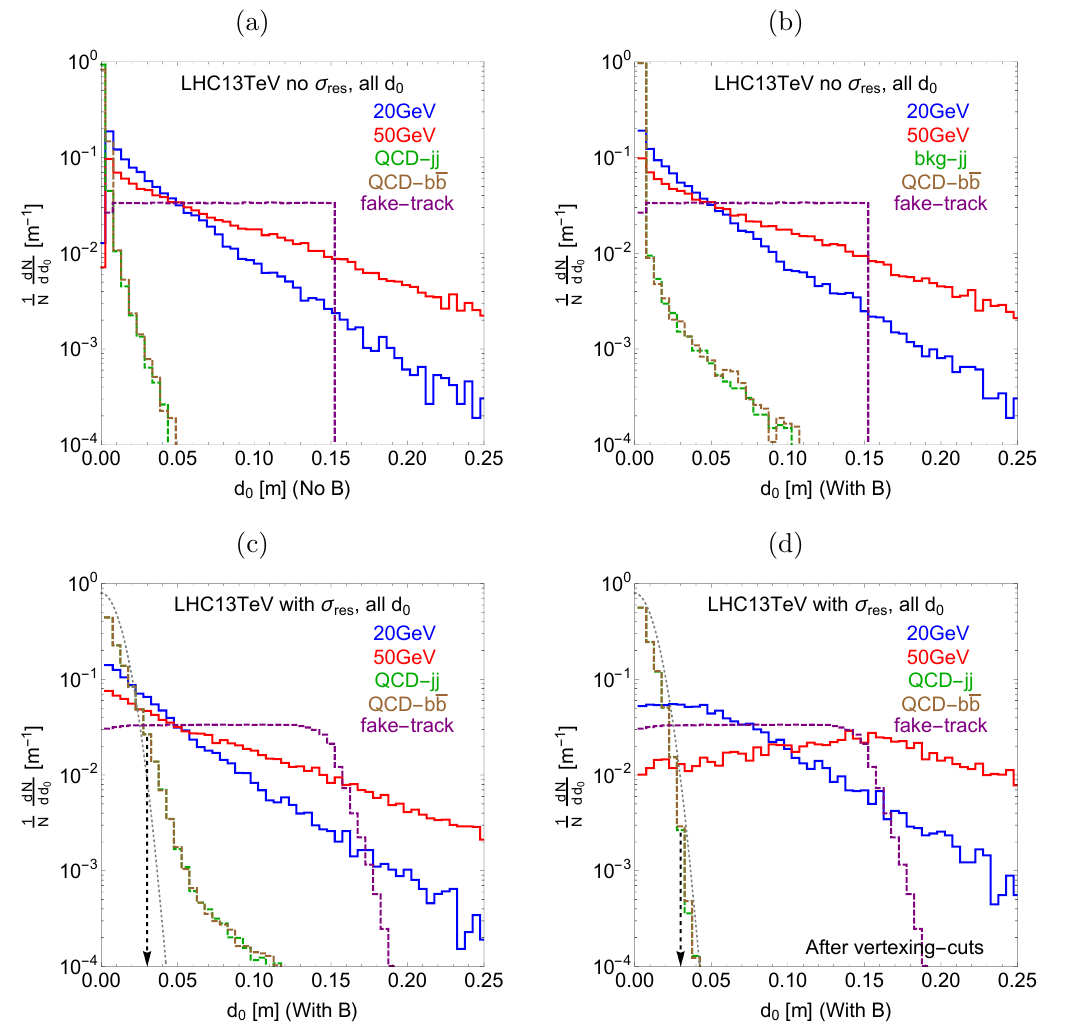
Figure 6 . The distributions of the transverse impact parameter d 0 for the QCD background, the fake-track background and the signal. Panel (a) has no angular resolution effect and no magnetic field. Panel (b) has no angular resolution effect but with a magnetic field of 3 . 8 T. Panel (c) has the angular resolution effect and the magnetic field. Panel (d) has both effects, and with vertexing-cuts imposed. The dotted gray lines are the Gaussian function with a spread of 0.015 m, corresponding to the angular resolution times the z coordinate of the